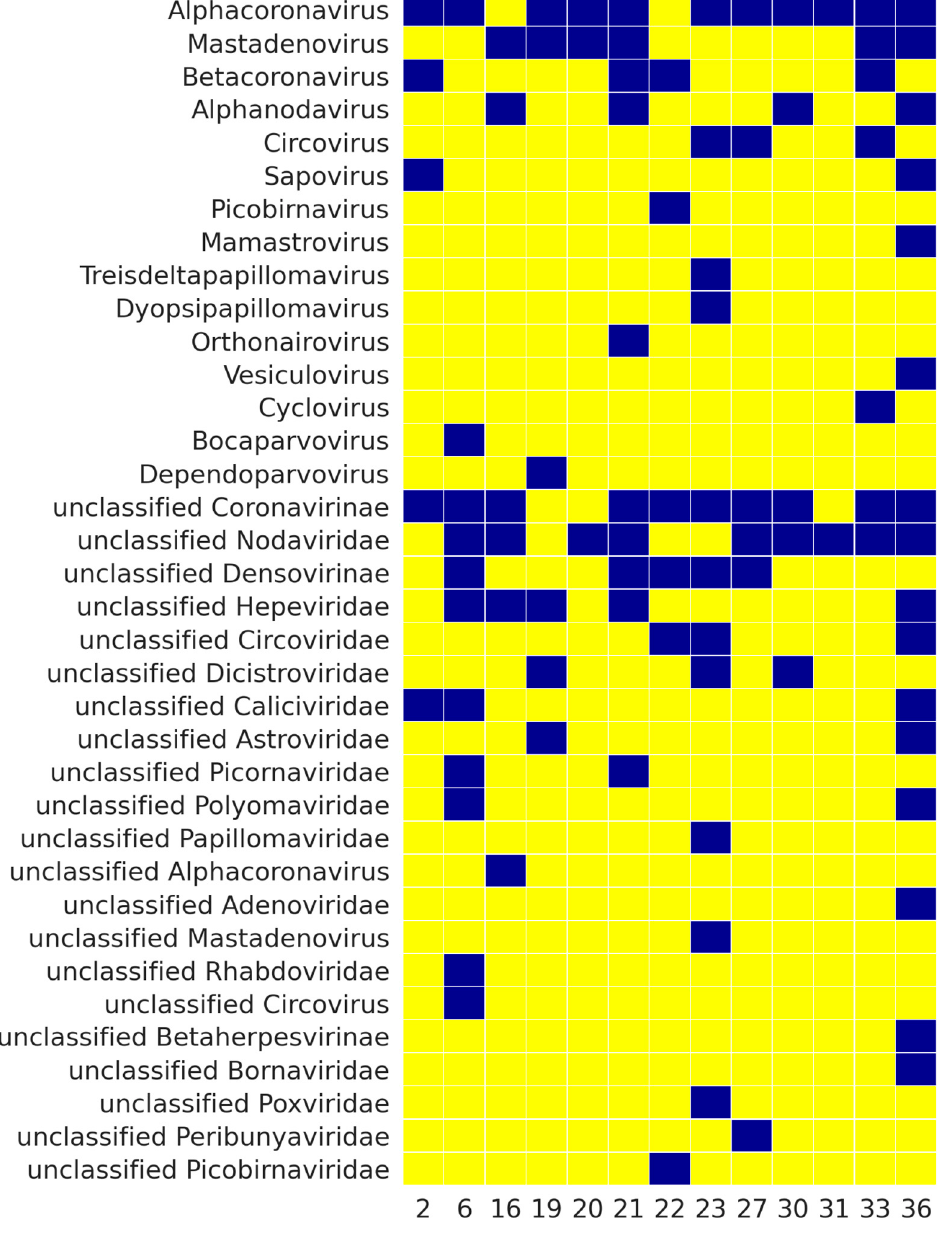
Figure 3. Presence of reads of viral fragments in bat samples based on sequencing results. Only those viral genera which bats can host are presented. Blue rectangles correspond to the presence of the related viruses in the sample, yellow rectangles correspond to the absence. Numbers at the bottom represent bat samples.